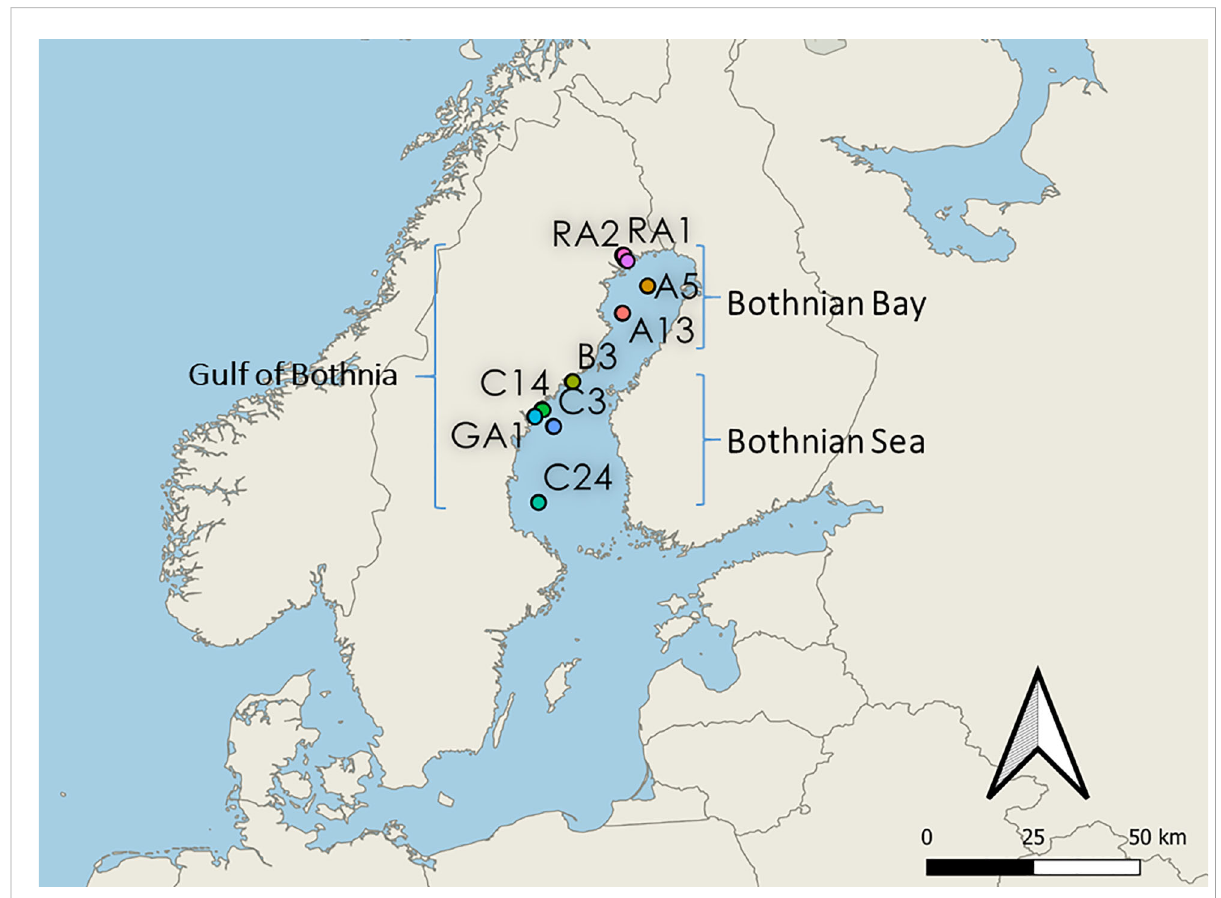
FIGURE 1 Map of the stations in the Gulf of Bothnia. Northern stations RA1, RA2, A5 and A13 are located in the Bothnian Bay basin (northern Gulf of Bothnia). Southern stations B3, C14, GA1, C3 and C24 are located in the Bothnian Sea basin (southern Gulf of Bothnia). Costal stations: RA1, RA2, B3, C14 and GA1. Offshore stations: A5, A13, C3 and